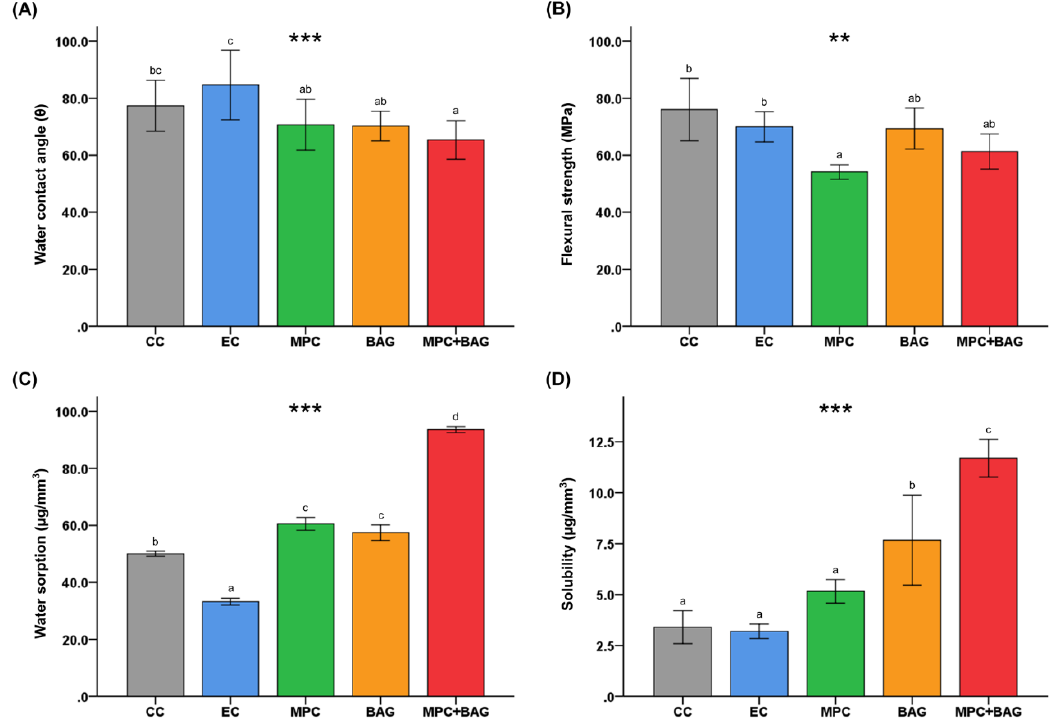
Figure 1. The water contact angle ( A ), flexural strength ( B ), water sorption ( C ), and water solubility ( D ) of the samples: Commercial control (CC), experimental control of 50 wt% resin matrix + 50 wt% glass filler (EC), 48.5 wt% resin matrix + 48.5 wt% glass filler + 3 wt% MPC (MPC), 50 wt% resin matrix + 37.5 wt% glass filler + 12.5 wt% BAG (BAG), and 48.5 wt% resin matrix + 36.38 wt% glass filler + 12.12 wt% BAG + 3 wt% MPC (MPC + BAG). The di ff erent letters above the bars indicate the significant di ff erences. *** p < 0.001, ** p < 0.01 for comparison between the groups.